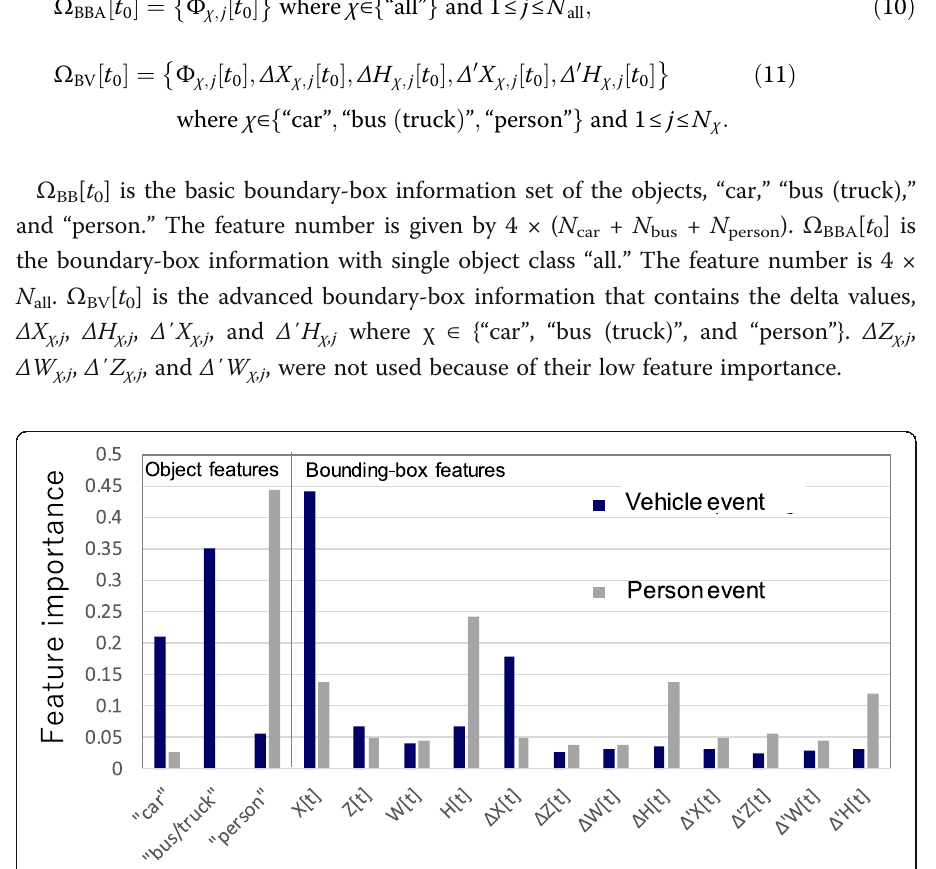
Fig. 9 Feature importance of Φ χ ,j [ t 0 ], Δ Φ χ ,j [ t 0 ], and Δ ′ Φ χ ,j [ t 0 ] for T F of 1.0 in the vehicle event and person